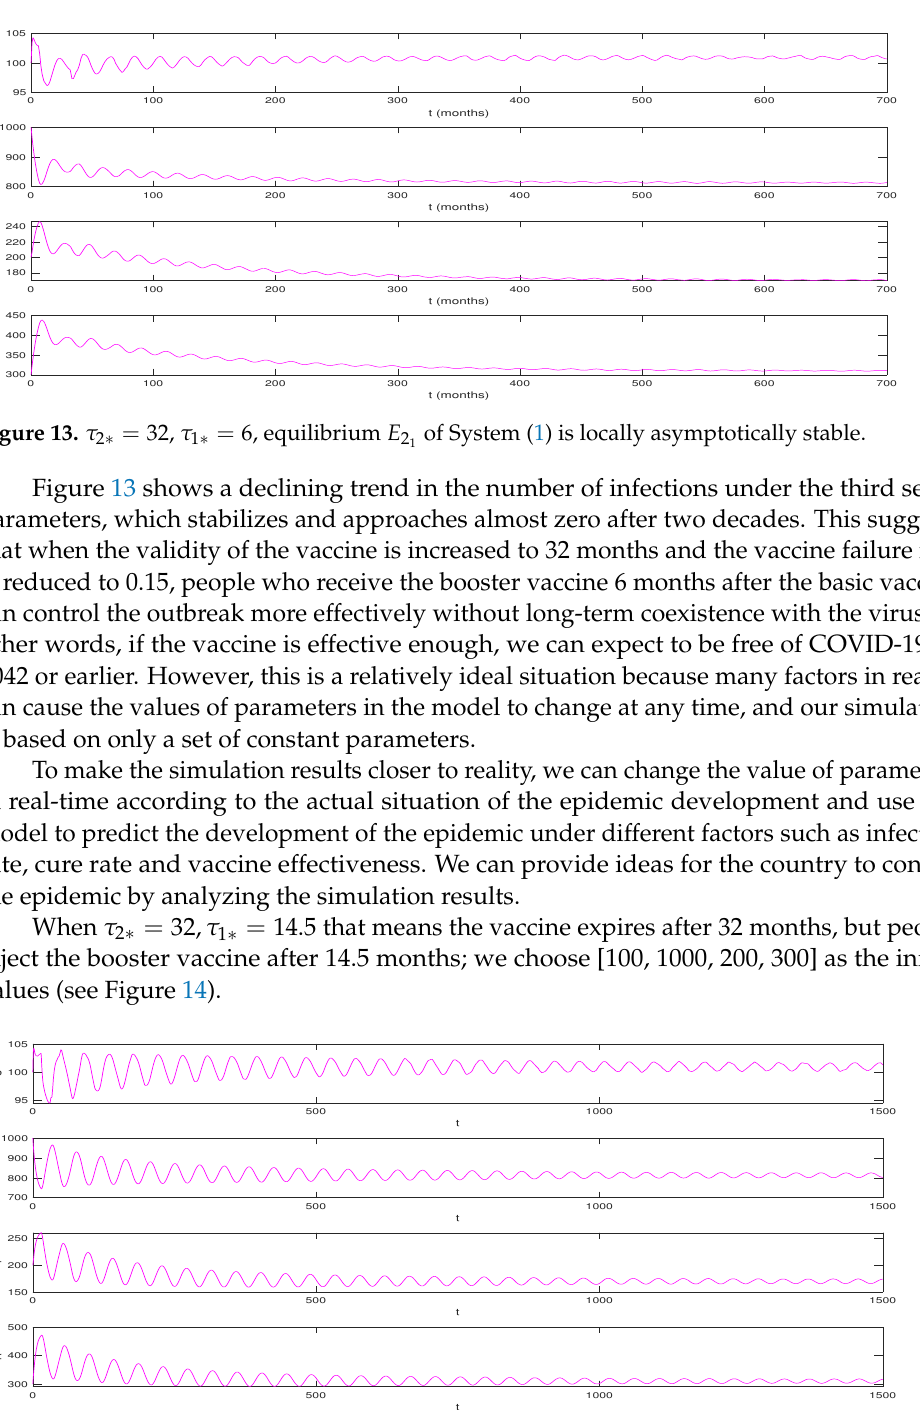
of System (1) is locally asymptotically 1